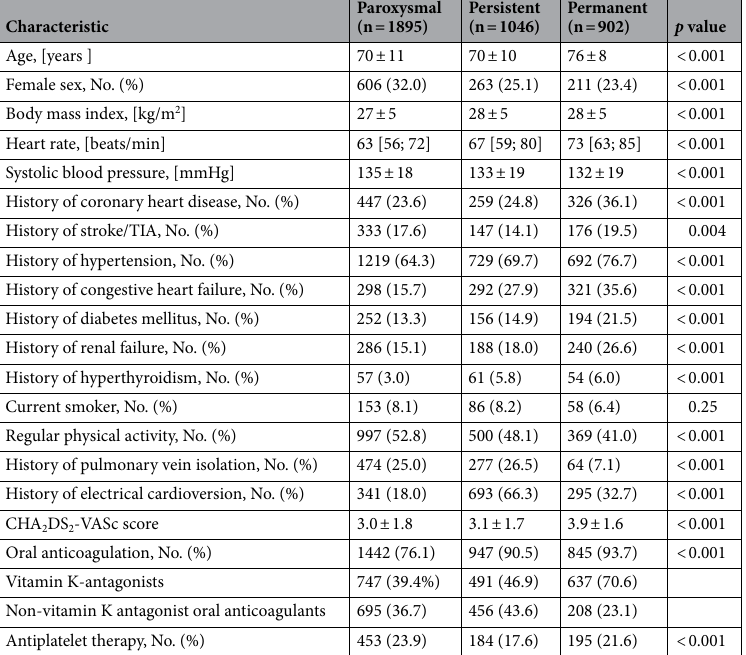
Table 1. Baseline characteristics stratified by baseline atrial fibrillation type. Data are means ± SD, medians (IQR) or counts (percentages); p values were based on ANOVA, Kruskal–Wallis-Tests or Chi-Square tests as appropriate. TIA transient ischemic